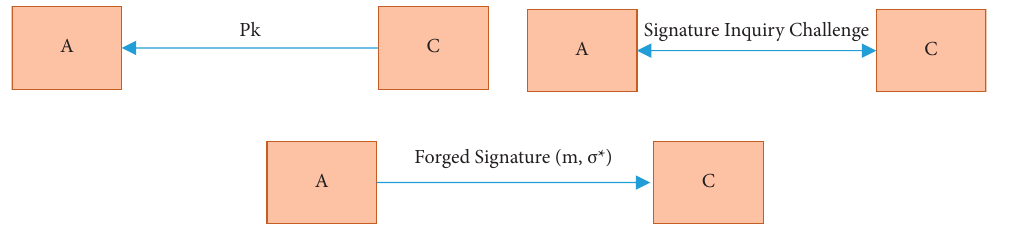
Figure 4: Adaptive CMA game of digital signature system.